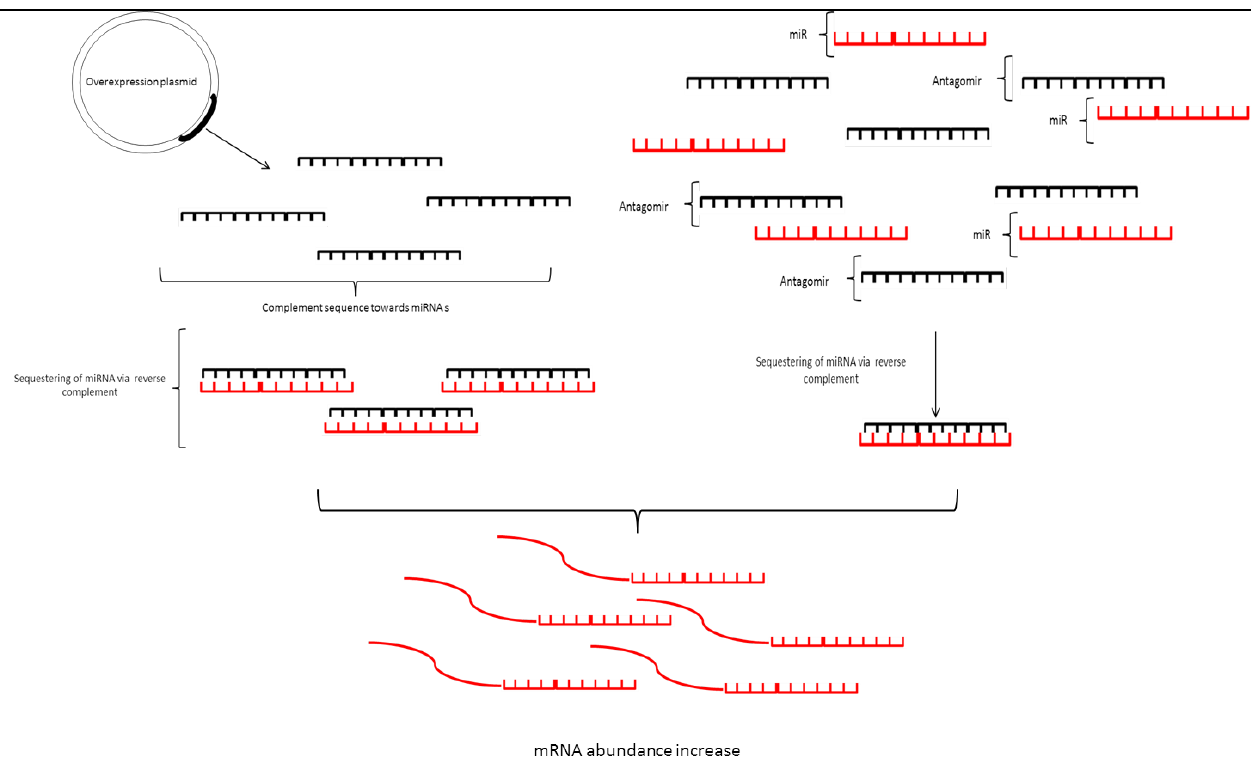
Figure 4. Tools for regulating miRNA; miRNA sponges use overexpression plasmids to produce miRNA target sequence which sequesters miRNAs reducing binding on target mRNA thus increasing target mRNA expression whereas antagomir is a complementary sequence of short RNA that binds mRNA via base pairing, the use of antagomir prevents miRNA from inducing mRNA cleavage thus resulting in increase in target